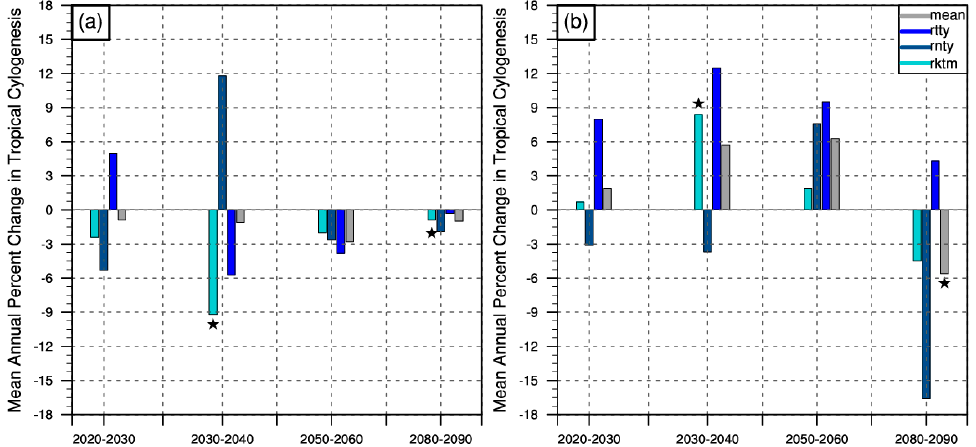
Figure 10. Mean annual percent change in tropical cyclogenesis (%) in the future ensemble runs for: ( a ) the North Atlantic Ocean and ( b ) the Eastern North Pacific Ocean with respect to the reference period (1990–2000). The stars indicate that changes have a 95% significance level applying the Kolmogorov–Smirnov two-sample test.